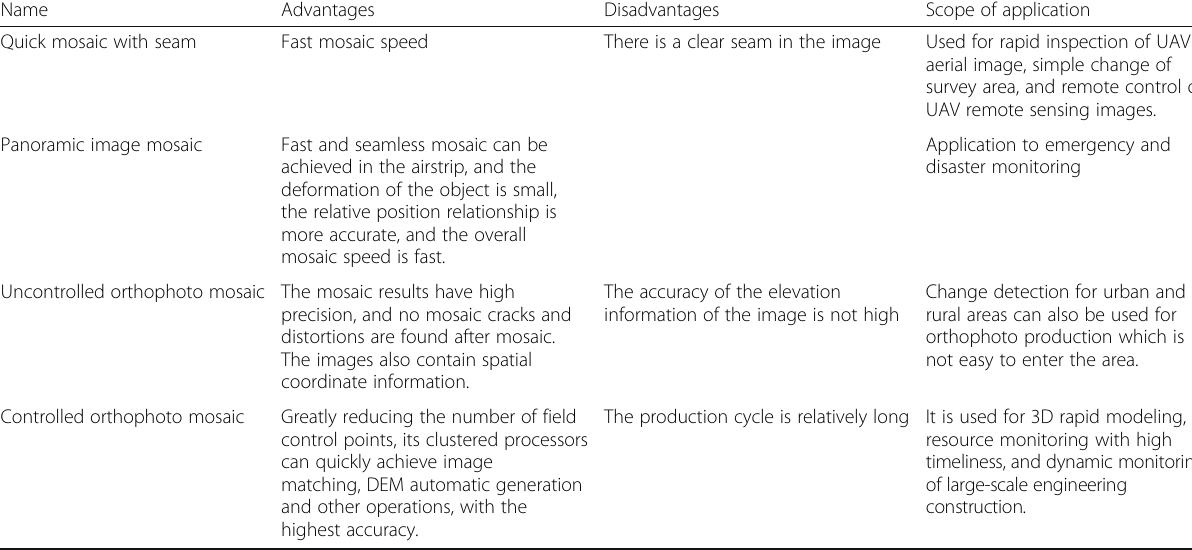
Table 1 Comparison of four UAV low-altitude remote sensing image mosaic